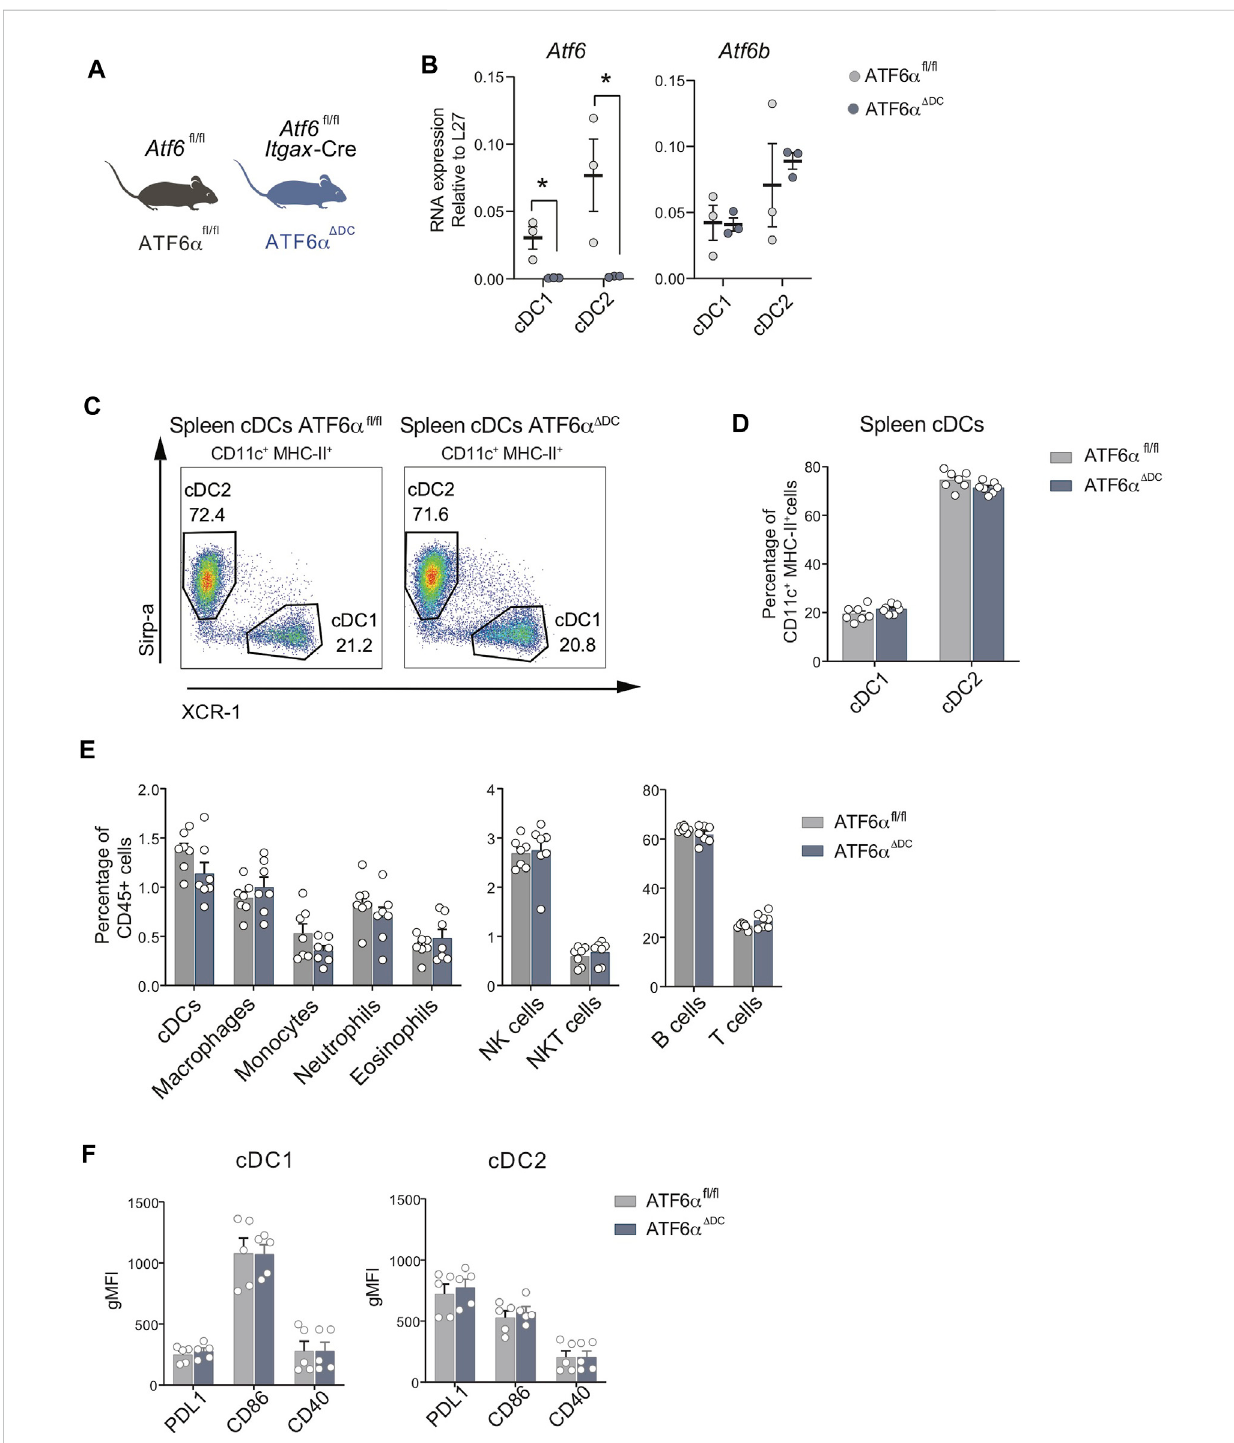
FIGURE 1 ATF6 α de fi ciency does not alter cDC composition in spleen. (A) Schematic representation of ATF6 α Δ DC mouse model. (B) Quanti fi cation of L27- relative expression of Atf6 and Atf6b mRNA in cDC1s and cDC2s sorted from spleen of ATF6 α fl / fl ( n = 3 mice) and ATF6 α Δ DC mice ( n = 3 mice). Quanti fi cation was performed by qPCR. Each symbol represents one mouse obtained from two independent experiments. (C) Representative fl ow cytometry plots showing distribution of cDC1s and cDC2s in spleen of ATF6 α fl / fl and ATF6 α Δ DC mice. Cells were pre-gated as single live CD45 + , CD64 − , F4/80 − , B220 − , CD3 − , LY6G − , NK1.1 − , Ly6C − /int , CD11b + , CD11c + , MHC-II + . (D) Percentage of cDC1s and cDC2s relative to CD11c + MHC-II + cells in spleenofATF6 α fl / fl ( n =7mice)andATF6 α Δ DC mice( n =7mice).Bargraphdepictsmeanpercentageofcells(±s.e.m.).Eachsymbolrepresentsonesample obtained from3independentexperiments. (E) PercentageofcDCs,macrophages,monocytes, neutrophils,eosinophils,NK,NKT,BandTcellsrelativeto the total percentage of CD45 + cells in spleen of ATF6 α fl / fl ( n = 7 mice) and ATF6 α Δ DC mice ( n = 7 mice). Bar graph depicts mean percentage of cells (±s.e.m.). Each symbol represents one sample obtained from 3 independent experiments. (F) Quanti fi cation of costimulatory molecules in cDC1s and cDC2sfromspleenofATF6 fl / fl ( n =5mice)andATF6 α Δ DC mice( n =5mice).Theidenti fi cationofco-stimulatorymoleculeswascarriedoutbylabelingwith antibodies. Each symbol represents the sample obtained from a mouse in three independent experiments. For statistical analyses in (B – F) a non- parametric Mann-Whitney test was used, * p <